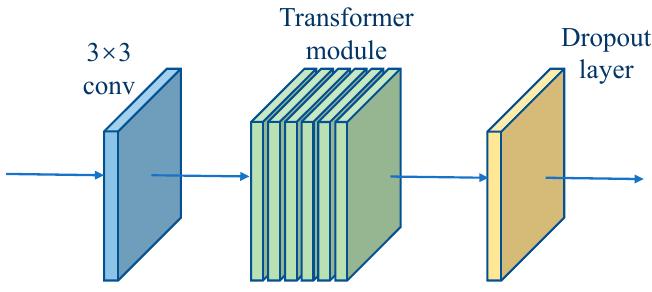
Figure 5. Feature storage and return module.